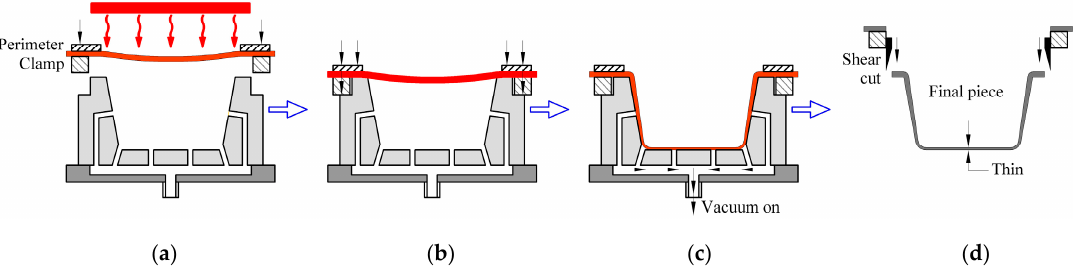
Figure 1. Schematic of basic vacuum thermoforming. ( a ) Heating; ( b ) sealing or pre-stretch; ( c ) forming and cooling; and ( d ) demolding and trimming.